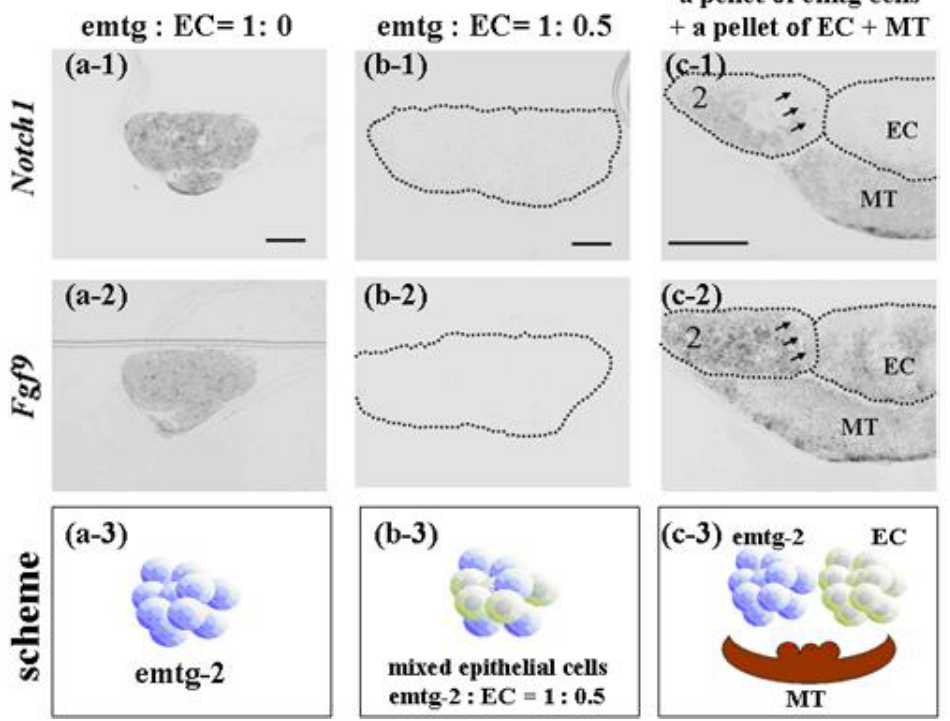
Figure 12. In-situ hybridization of Notch1 and Fgf9 in germs reconstructed with a modified method and cultured for one day. ( a-1 , 2) Gene expression in a pellet of emtg-2 cells. ( b-1 , 2) Gene expression in a pellet of emtg-2 cells and EC (1:0.5). ( c-1 , 2) Gene expression in reconstructed germs with a pellet of emtg-2 cells and a pellet of EC and MT. ( a-1 , b-1 , c-1 ) Expression of Notch1 in reconstructed germs. ( a-2 , b-2 , c-2 ) Expression of Fgf9 in reconstructed germs. ( a-3 , b-3 , c-3 ) Illustration of the modified method. 2: emtg-2 cells, EC: dental epithelial cells, MT: dental mesenchyme. (cid:54)(cid:70)(cid:68)(cid:79)(cid:72)(cid:3)(cid:69)(cid:68)(cid:85)(cid:86)(cid:3)(cid:68)(cid:85)(cid:72)(cid:3)(cid:20)(cid:19)(cid:19)(cid:3)(cid:541)(cid:80)(cid:3)(cid:76)(cid:81)(cid:3)(cid:11) a-1 and b-1 ) and ( a-1 , a-2 , b-1 and b-2 (cid:12)(cid:3)(cid:68)(cid:85)(cid:72)(cid:3)(cid:68)(cid:87)(cid:3)(cid:87)(cid:75)(cid:72)(cid:3)(cid:86)(cid:68)(cid:80)(cid:72)(cid:3)(cid:80)(cid:68)(cid:74)(cid:81)(cid:76)(cid:73)(cid:76)(cid:70)(cid:68)(cid:87)(cid:76)(cid:82)(cid:81)(cid:17)(cid:3)(cid:54)(cid:70)(cid:68)(cid:79)(cid:72)(cid:3)(cid:69)(cid:68)(cid:85)(cid:3)(cid:76)(cid:86)(cid:3)(cid:21)(cid:19)(cid:19)(cid:3)(cid:541)(cid:80)(cid:3)(cid:76)(cid:81)(cid:3)(cid:11) c-1